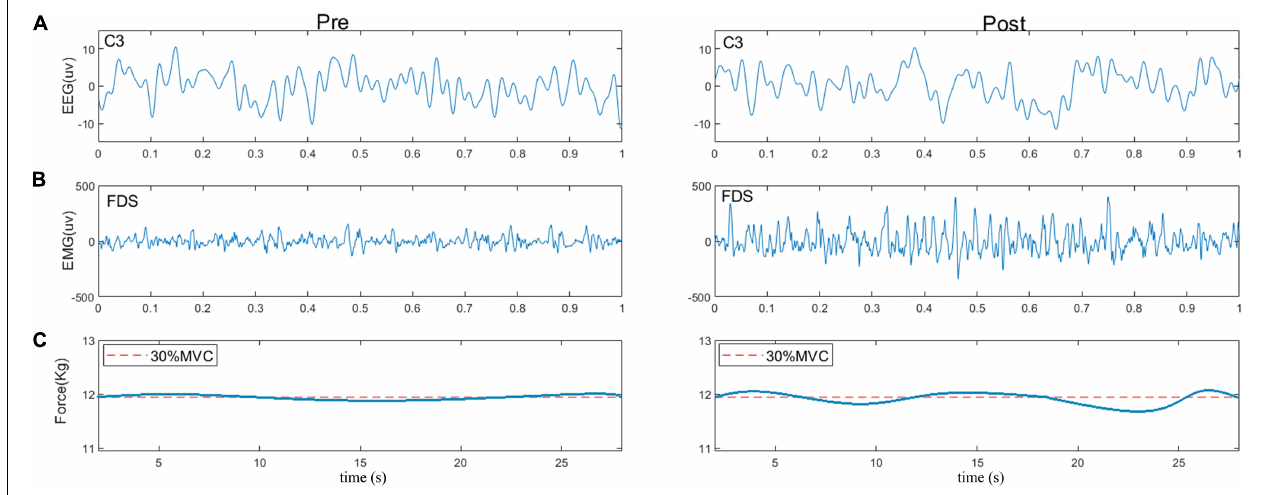
FIGURE 3 | Typical examples of (A) raw EEG signals (C3), (B) raw sEMG signals (FDS), and (C) force performance during pre- and post-fatigue tasks. The red dotted line represents the target